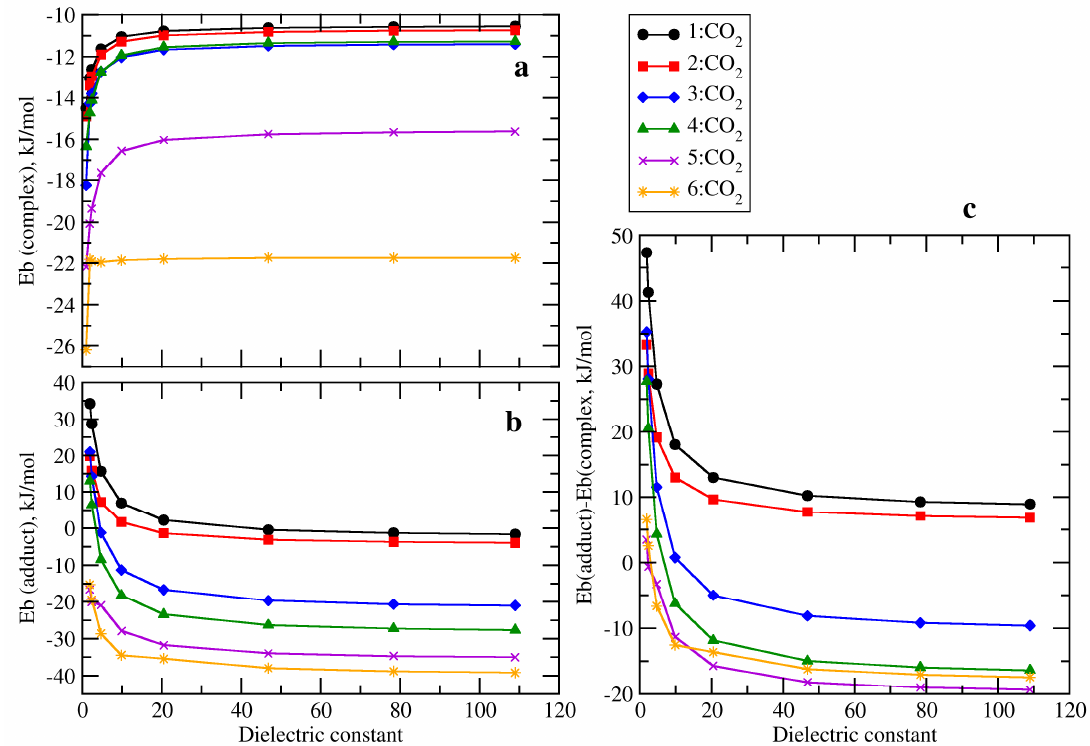
Figure 6 . ( a ) Evolution of the binding energies of the complex; ( b ) Adduct vs. the dielectric constant of the solvent; ( c ) Relative energy between the complex and adduct for each system vs. the dielectric constant of the solvent. In-plot: zoom into the inner region with low dielectric